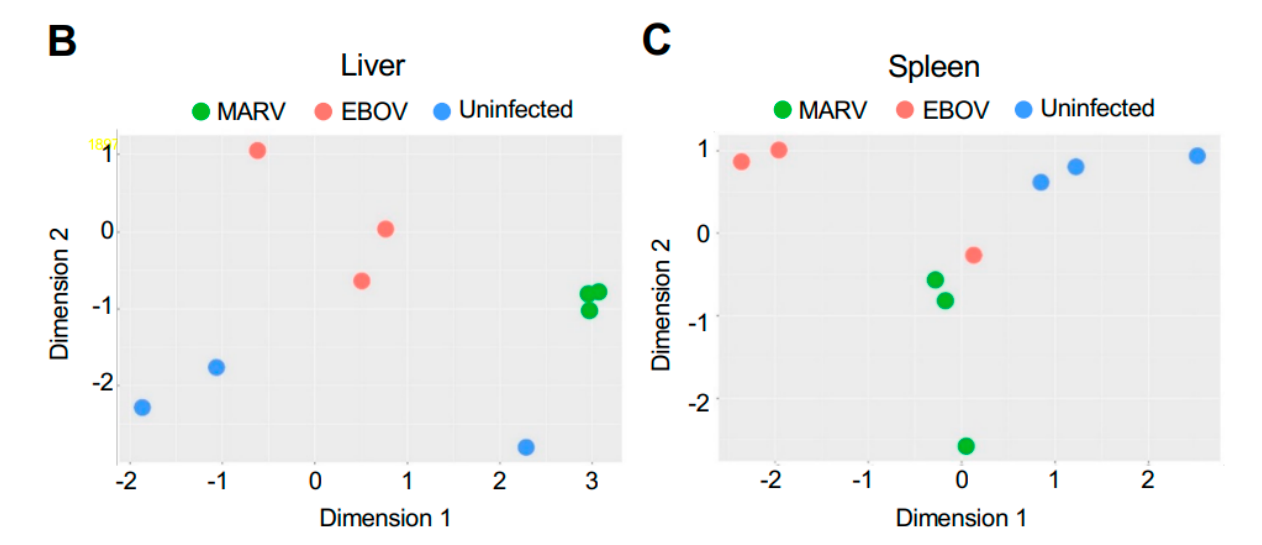
Figure 2. Changes in gene expression patterns in bats after infections with MARV and EBOV. ( A ). An UpSet plot of the gene expression data in the livers of bats infected with MARV, EBOV, or uninfected. Responsive genes are placed into six groups (MARV/Uninf, MARV/EBOV, EBOV/Uninf, EBOV/MARV, Uninf/MARV, and Uninf/EBOV) listed in the lower left panel. Each group consists of genes whose expression is increased at least 2-fold versus the comparator, e.g., EBOV/Uninf comprises genes upregulated in EBOV-infected bats compared to the uninfected bats, while Uninf/EBOV comprises genes downregulated in EBOV-infected bats compared to the uninfected bats. A gene can belong to multiple groups, as indicated by the blue dots. The first vertical bar in the graph represents the 743 genes that are unique to the MARV/Uninf set, while the last bar represents the 5 genes that occur only in the combination of 3 sets, EBOV/MARV, EBOV/Uninf and MARV/Uninf. In the lower left bar plot, the first horizontal bar represents the 197 genes that belong to Uninf/EBOV, which is a sum of the values for the four combinations which include the Uninf/EBOV comparison (36 + 138 + 5 + 18). ( B , C ). Multidimensional scaling (MDS) plots of the merged gene expression data in livers ( B ) and the spleens ( C ) of bats infected with MARV, EBOV, or uninfected. One uninfected bat in panel B is an outlier based on comparison to the two other uninfected bats, which is also seen in the correlations shown in Table S9. The difference for this bat may be explained by its reaction to some stimulus, either an infection or an injury; the animal has been excluded from the downstream analysis. Virus-specific signatures were also detected in kidneys (Figure S1), implying the response to filovirus infections extends to the whole animal. Table 1. Acute phase proteins in livers respond strongly to inflammatory